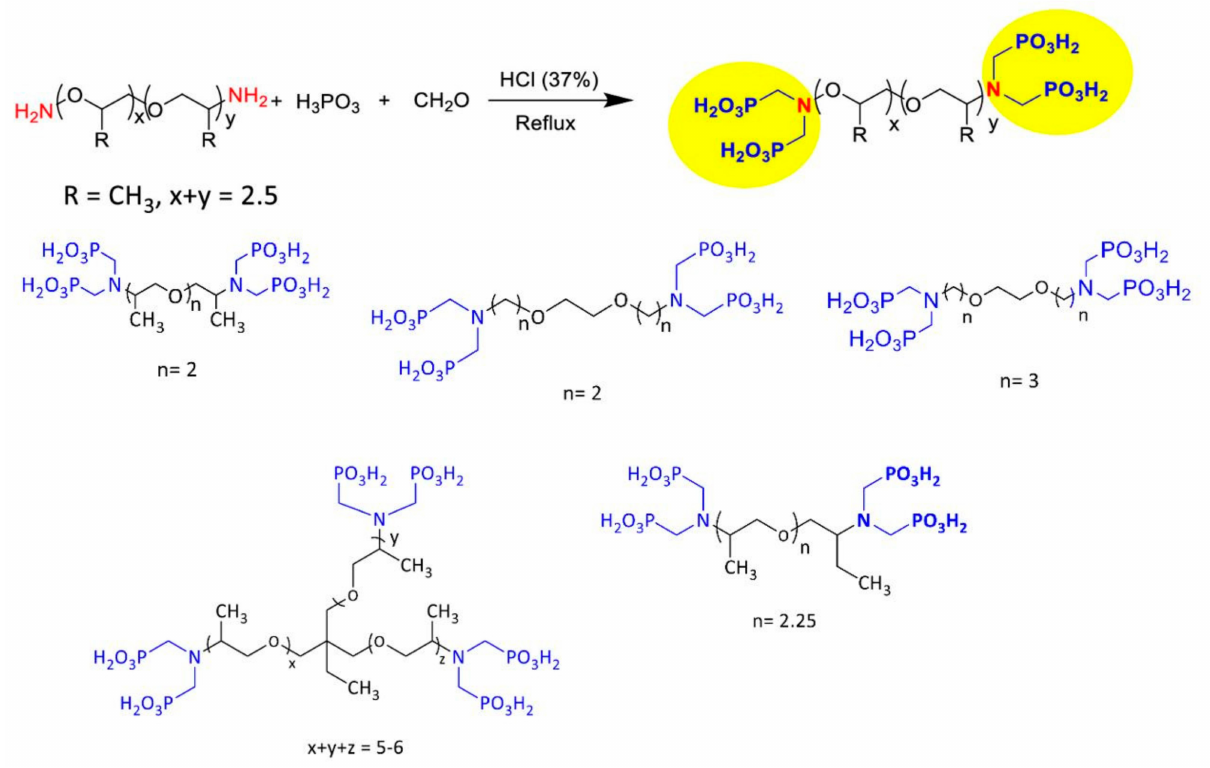
Figure 5. Synthesis and chemical structure of phosphonated polyetheramine derivatives